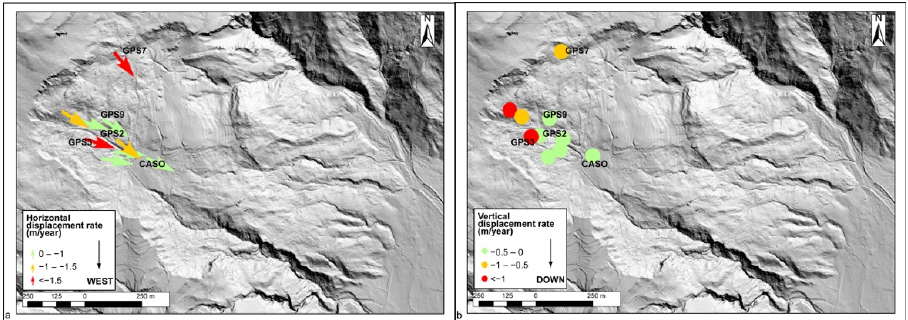
Figure 3. ( a ) Horizontal and ( b ) vertical displacement recorded by the cost-effective, single-frequency GPS network on the Cazzaso landslide between 1 January 2019–30 June 2021. The sensor data were used, with the exception of the data of the GP10, GP11, and GP12 stations, which are more recent and have a shorter time series than the other stations. Table 2. Location, displacement rate in the different components, and direction of movement of the monitoring stations shown in Figure 3. FUSE and TOLS are the reference sites deployed on stable structures far from the